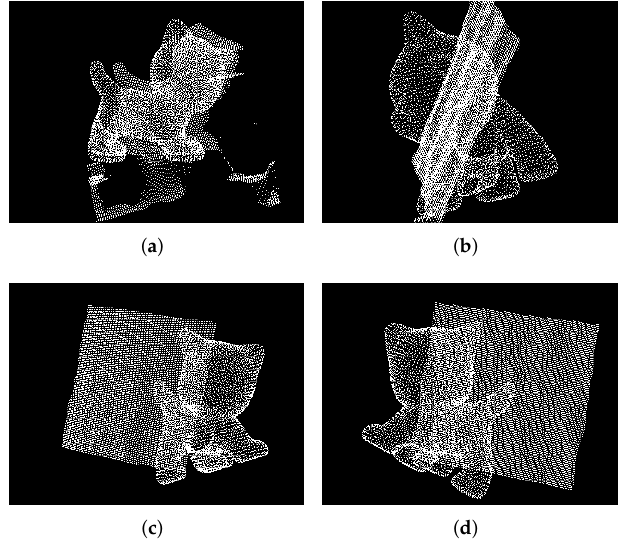
Figure 6. Object model reprojected into the point cloud captured by the depth sensor. ( a ) A real object in the scene; ( b ) the object model is reprojected on the photo; ( c ) the object model is reprojected behind the photo; ( d ) the object model is reprojected in front of the